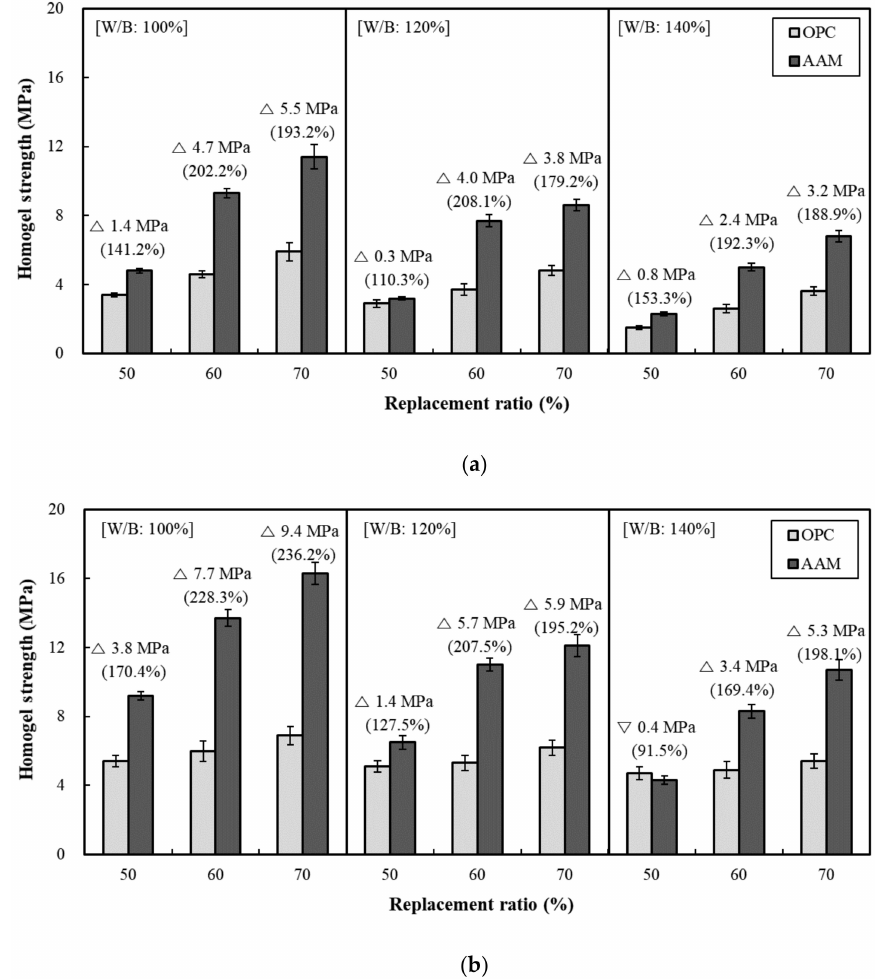
Figure 5. Homogel strength of OPC and AAC by replacement ratio: ( a ) 3 days ( b ) 7